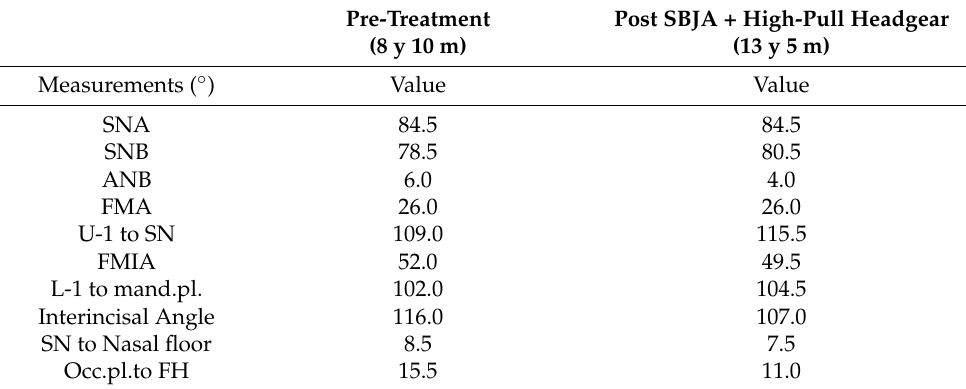
Table 5. Cephalogram angle measurements of Case